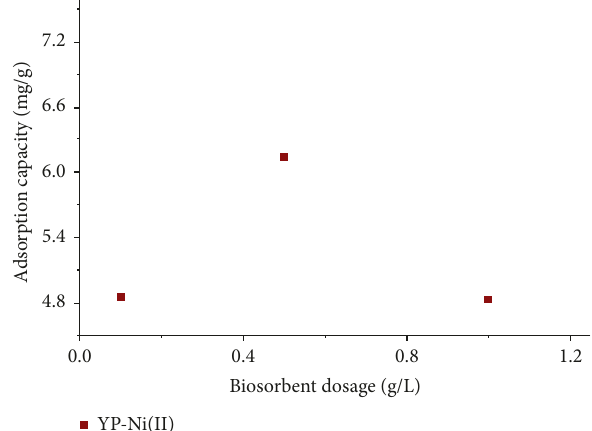
Figure 3: Effect of biosorbent dosage on adsorption capacity for nickel uptake.